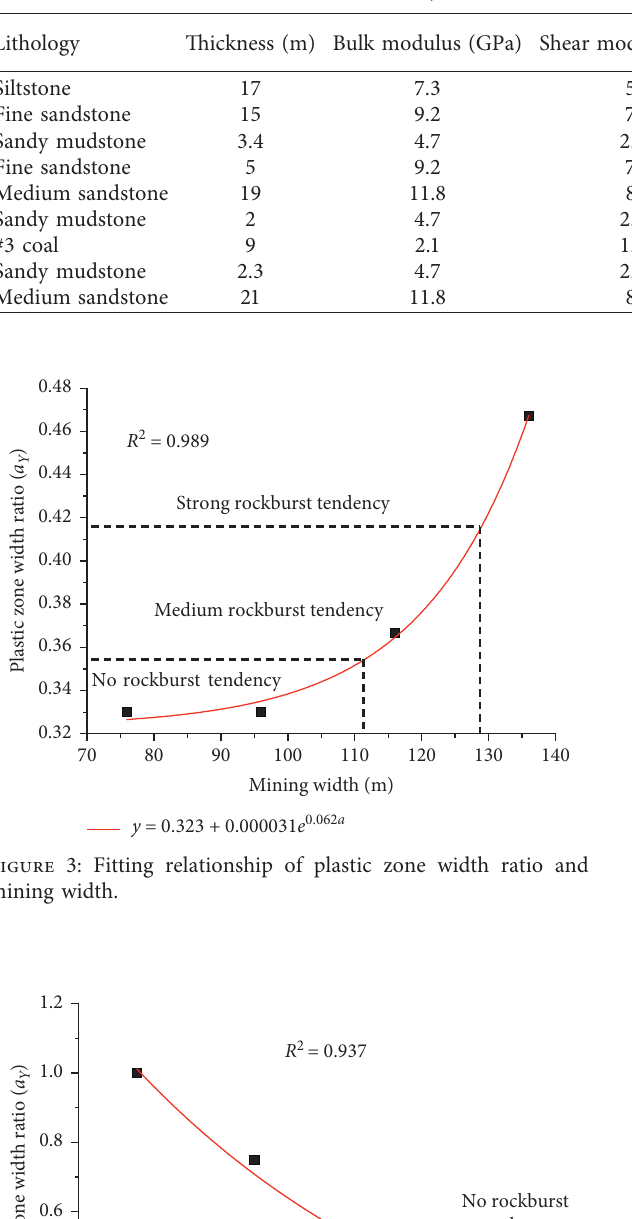
Table 2: Physical and mechanical parameters of the rock